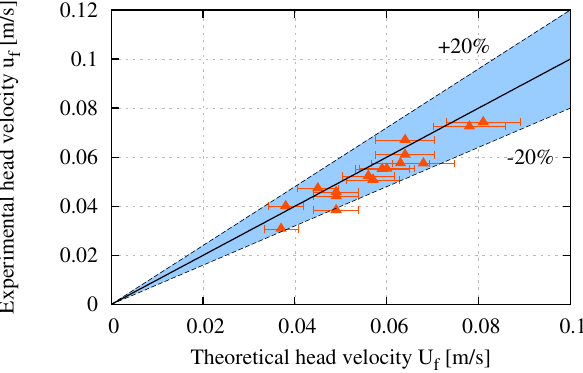
Figure 3. Comparison between the experimental values and the the- oretical predictions obtained by the empirical expression proposed by Didden and Maxworthy (1982) with C = 1 . 05.